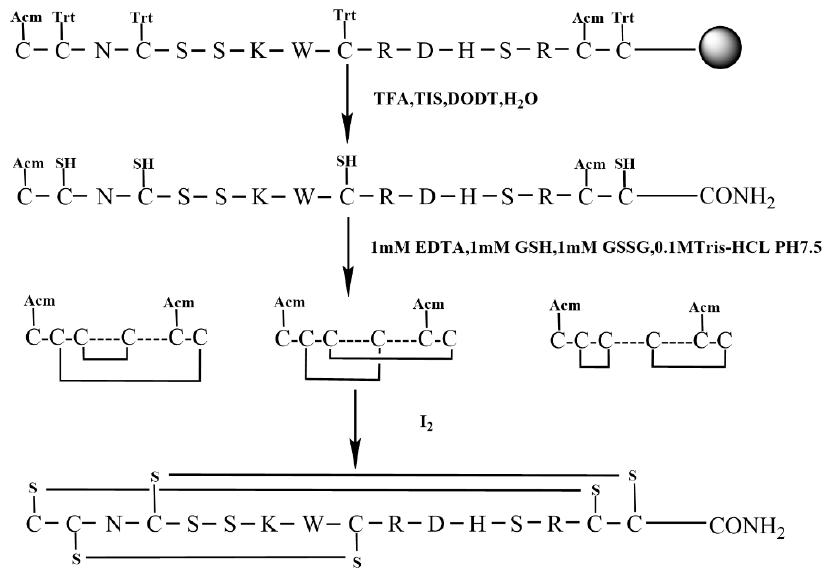
Figure 4. Semi-selective strategy for synthesis KIIIA (Scheme 2).